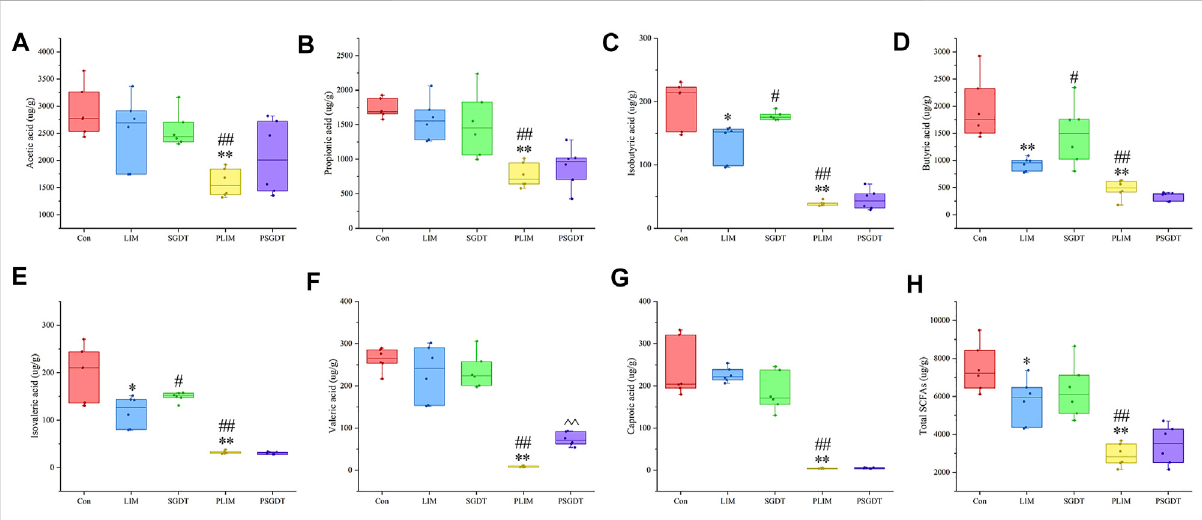
FIGURE 5 Contents of SCFAs in cecum contents of rats in each group. (A) Acetic acid (B) Propionic acid (C) Isobutyric acid (D) Butyric acid (E) Isovaleric acid (F) Valeric acid (G) Caproic acid (H) Total SCFAs. * p < 0.05, **p < 0.01, compare with Con; # p < 0.05, ## p < 0.01, compare with LIM; ^^ p < 0.01, compare with